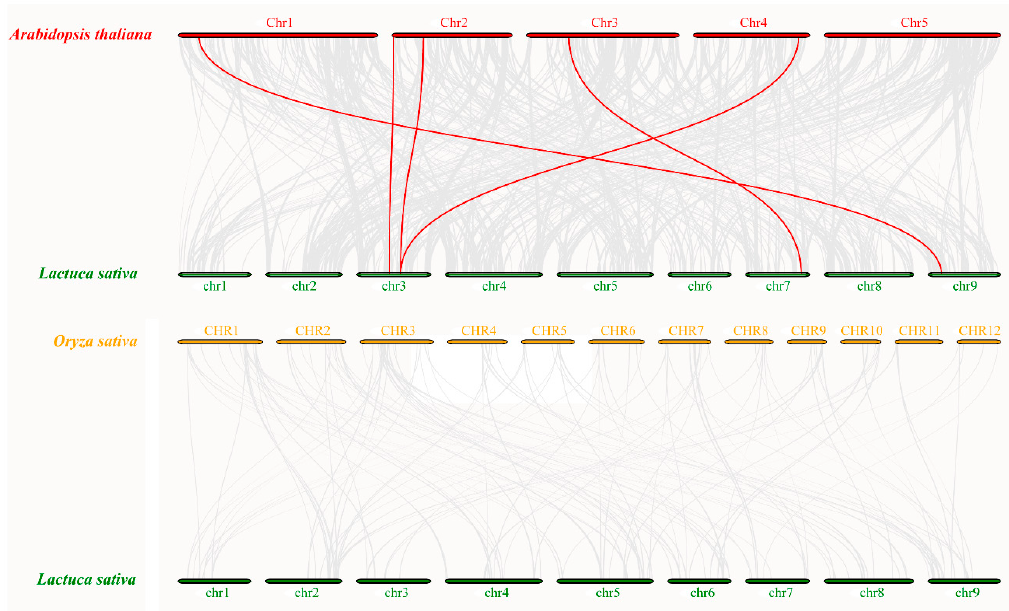
Figure 6. Comparative analysis of synteny among lettuce, Arabidopsis, and rice. The chromosomes of three plants are shown by colored circular rectangles. Grey and red curves represent the identified collinear blocks with the genomes and the collinear with MAPK genes, respectively.